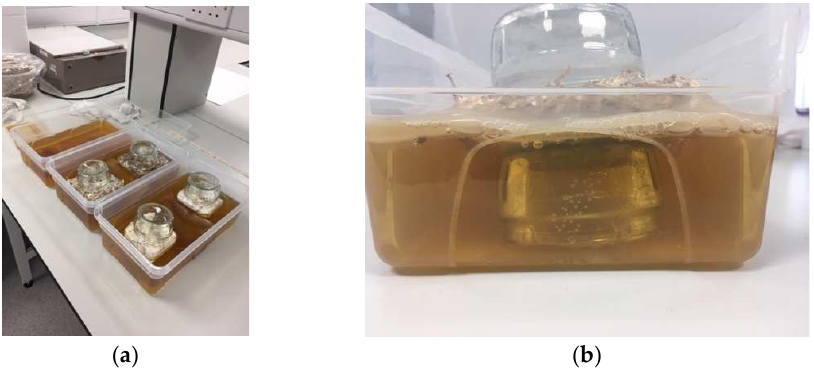
Figure 2. ( a ) Setup of experiments 2 and 3 with (from right to left) air-dried mycelium, living mycelium, and a control culture. ( b ) Closeup of the positioning of the tiles within the liquid using jars (image credit: authors).